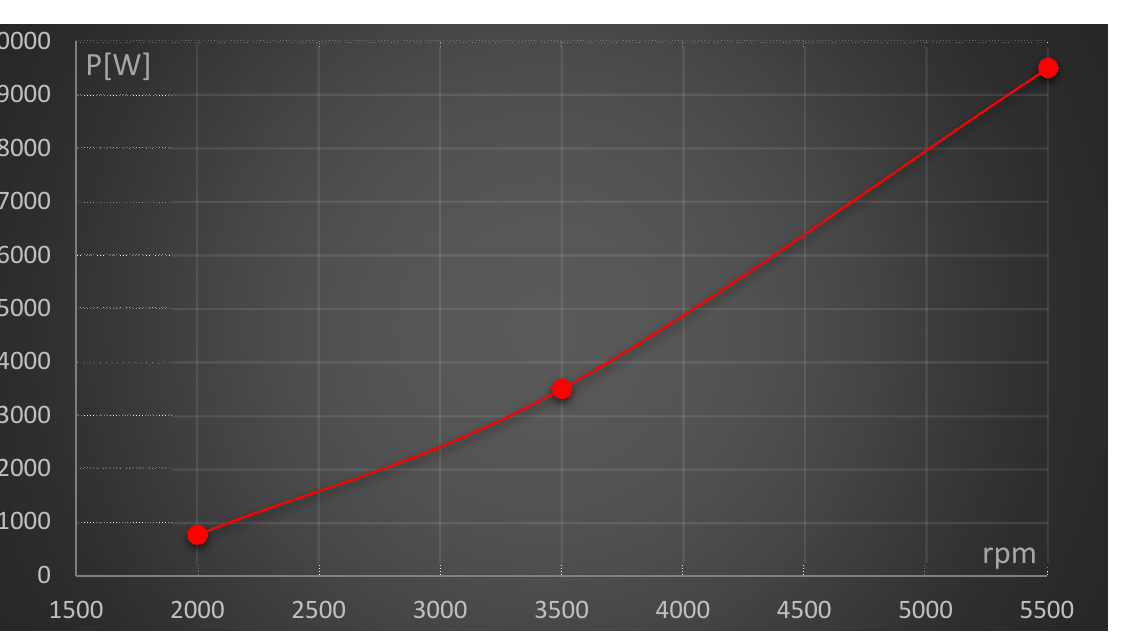
Figure 8. ( a ) GT 20 impeller, ( b ) operative map.